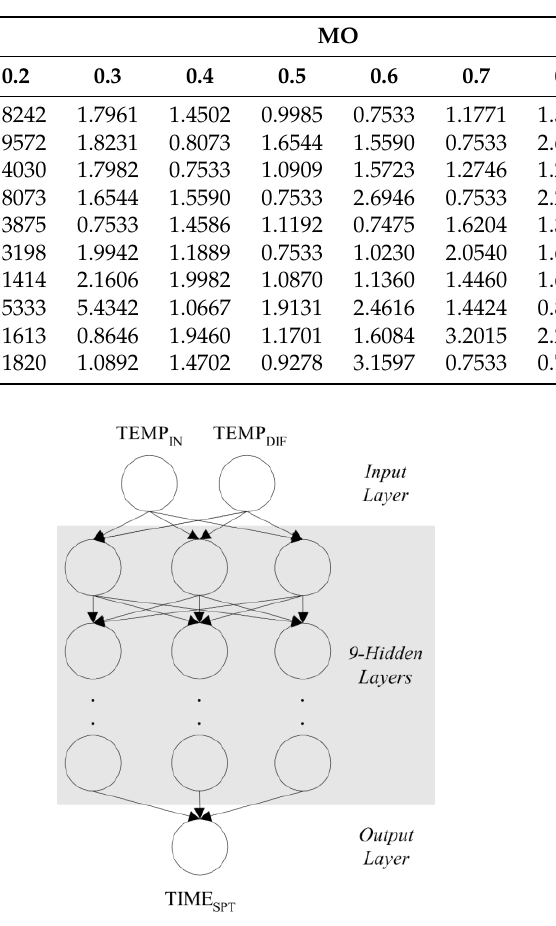
Table 7. RMSE between the simulated and predicted values for various numbers of MO and LR.